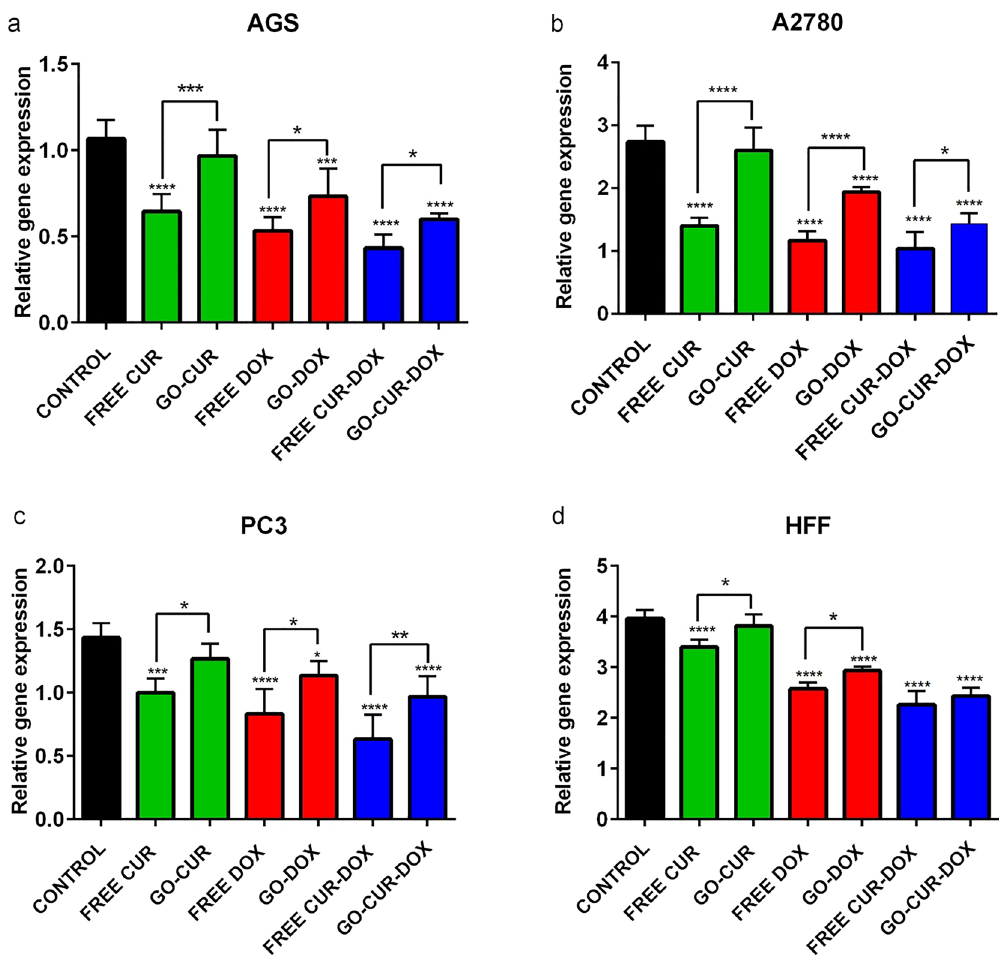
Figure 13. Effect of free CUR, GO-CUR, free DOX, GO-DOX, free CUR-DOX and GO-CUR-DOX on the expression of CDK2 in AGS, PC3, A2780 and HFF after 48 h. Results are expressed as the mean ± standard deviation (*p < 0.05) (**p < 0.001) (****p <